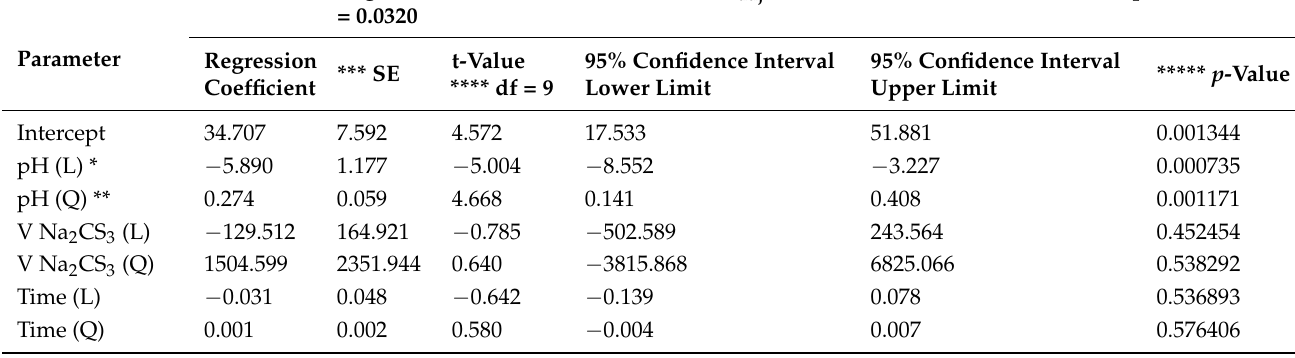
Table 7. Calculated linear (L) and quadratic (Q) coefficients of the fitted model by Statistica